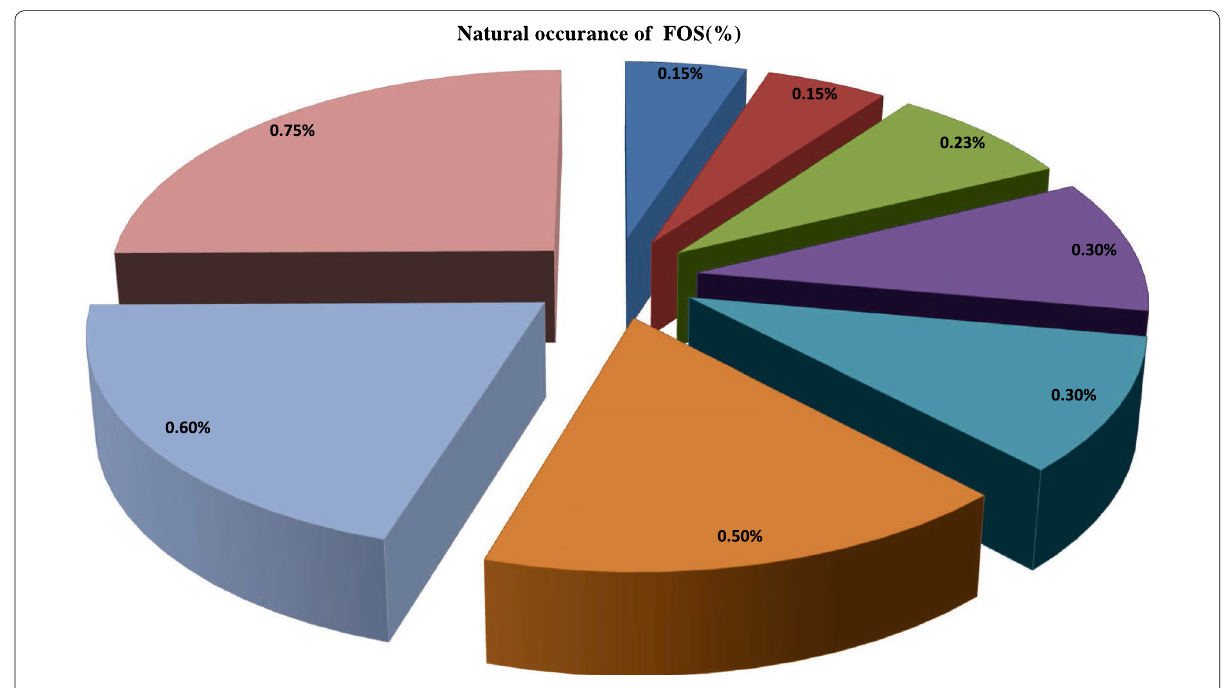
Fig. 2 Distribution of FOS in various natural